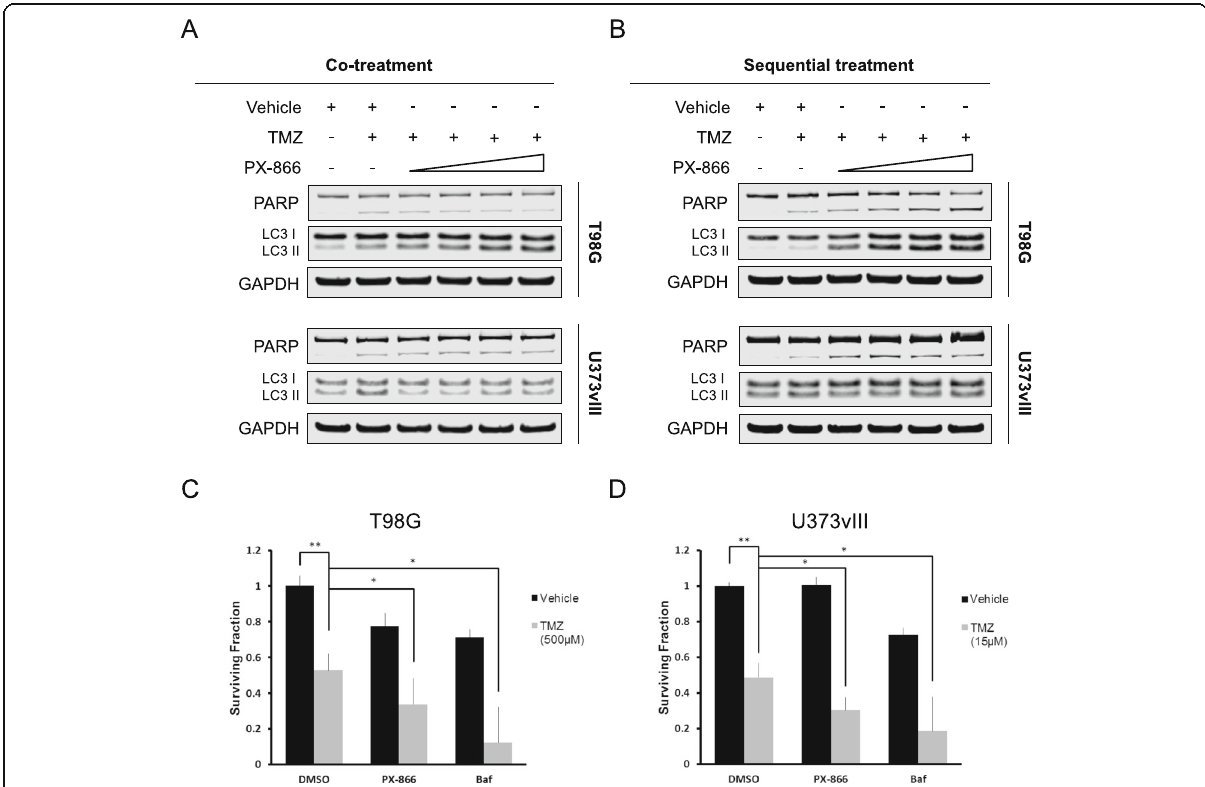
Fig. 5 TMZ and PX-866 cooperate to diminish survival. a T98G (EGFR WT) and U373vIII (EGFRvIII) were treated with TMZ (500 μ M) and increasing doses of PX-866 for 48 h (co-treatment). Both floating and remaining adherent cells were collected for analysis and western blotting for PARP and LC3 was used to assess apoptosis and autophagy, respectively. The triangle representing the dose escalation for PX-866 indicates: 0.125, 0.25, 0.5, and 1 μ M. b T98G and U373vIII cells were treated with TMZ (500 μ M) for 24 h, followed by the addition of PX-866 for another 24 h (sequential treatment). The triangle representing the dose escalation for PX-866 indicates: 0.125, 0.25, 0.5, and 1 μ M. T98G cells ( c ) and U373vIII cells ( d ) were treated with the indicated treatments for 24 h. Cells were trypsinized 24 h after drug treatment and re-plated in 35 mm dishes in triplicate and allowed to form colonies. After about 9 – 10 days, colonies were fixed (6% glutaraldehyde) and stained (0.5% crystal violet). The number of colonies were counted and presented as a bar graph. Values are the mean ± the standard deviation of three separate measurements, *, P < 0.05 and, **, P < 0.01. Data represents the mean and S.D. from three independent experiments with each experiment conducted in